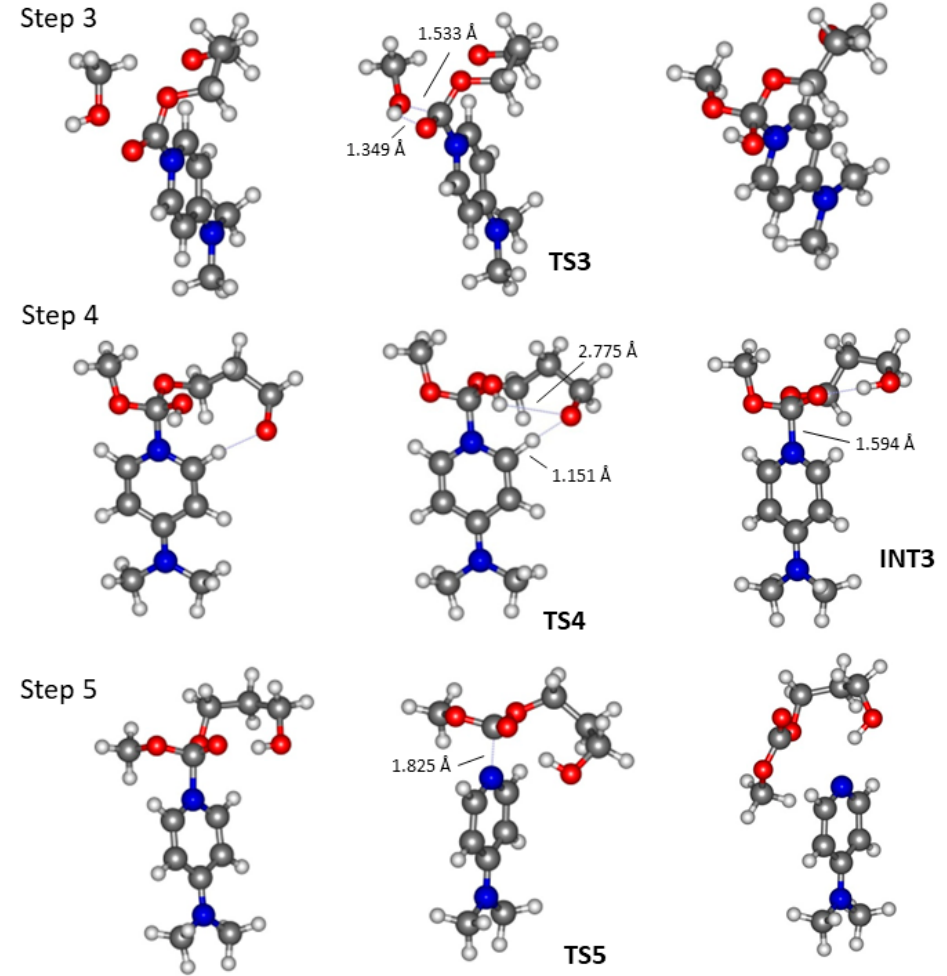
Figure 6. Optimized geometry structures of the species involved in the final steps of the nucleophilic mechanism of the DMAP-catalysed ring-opening polymerization of TMC. Colour code: C grey, O red, N blue and H white.